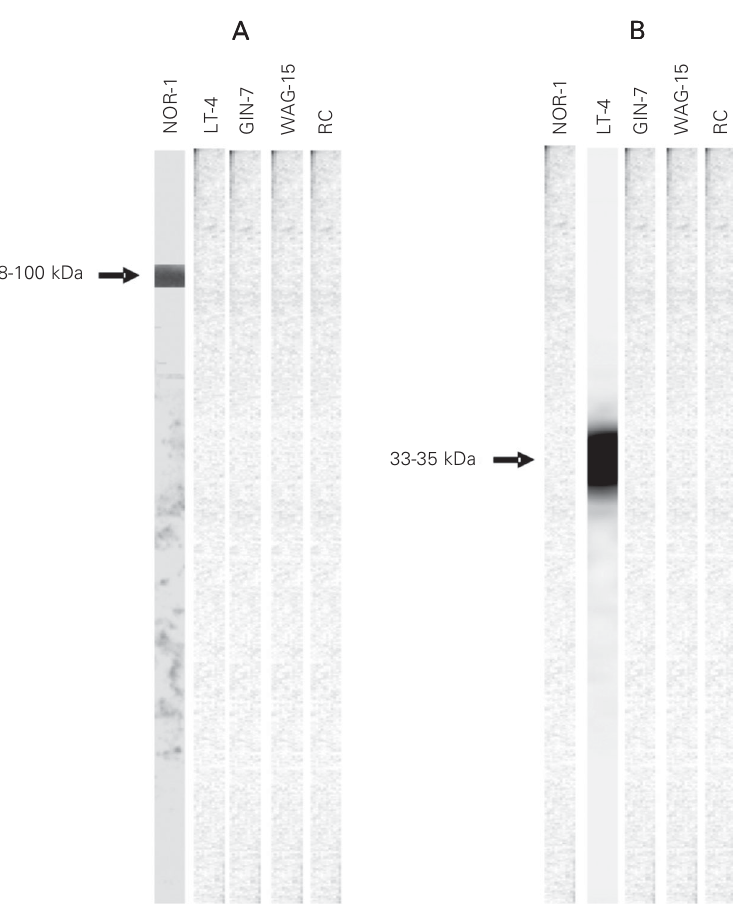
Figure 3. Immunohistochemical reaction of astrocytes with the monoclonal antibody NOR-1 for p24 gag of human T-lymphotro- pic virus type I. A , Histological preparation of the spinal cord of normal young rat. B , Human pri- mary cultures of normal astro- cytes. The arrows indicate a positive immunohistochemistry reaction. AST = astrocytes; NU =